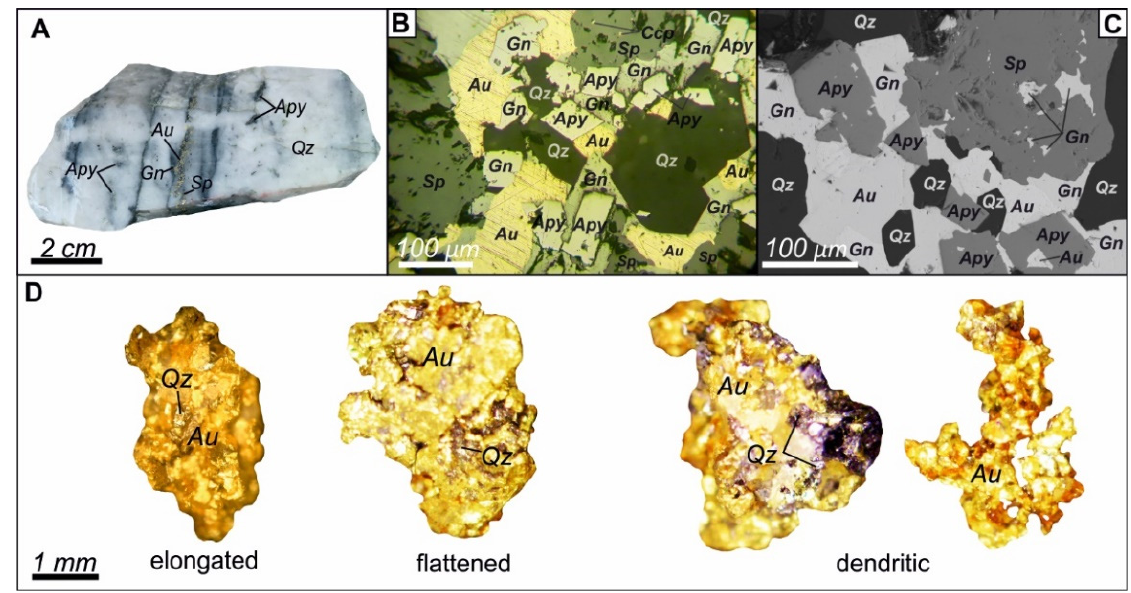
Figure 2. ( A – C ) Mineral composition of vein-type ores, and ( D ) morphology of native gold of Khangalas deposit. ( A ) Banded quartz with inclusions of native gold (Au), galena (Gn), sphalerite (Sp), and arsenopyrite (Apy); ( B , C ) intergrowths of native gold (Au), galena (Gn), sphalerite (Sp), and chalcopyrite (C с p) of the Au–polysulfide vein association and anhedral arsenopyrite (Apy) of quartz–pyrite–arsenopyrite vein association: ( B ) in reflected light, ( C ) in backscattered electrons. Hereafter, abbreviations for minerals are from [39].